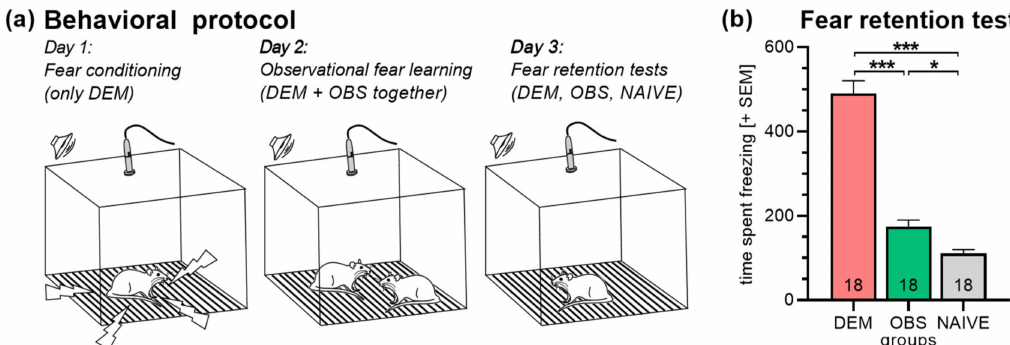
Figure 2. ( a ) Behavioral protocol of experiment 2 was identical to experiment 1, but no light–dark test was performed, and ultrasonic vocalization was recorded throughout the experiment. ( b ) In the retention test, DEM rats showed more freezing than OBS and NAIVE rats. OBS rats had significantly higher freezing scores than NAIVE rats, indicating observational fear learning in OBS rats. Abbreviations: DEM, demonstrator rats; OBS, observer rats; NAIVE, naive rats. Numbers in the bars indicate group sizes. *** p < 0.001, * p < 0.05; comparisons as indicated, after significant main effects in